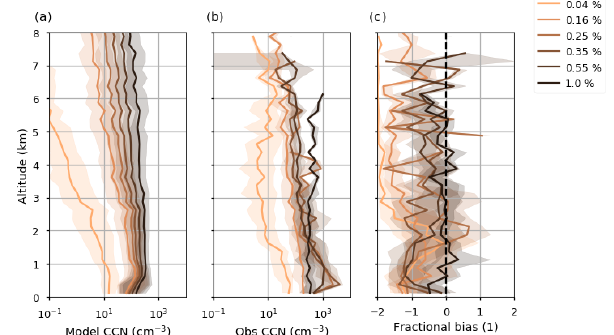
Figure 11. The vertical profile of median fractional bias in model and observed integrated aerosol number at different size cut-offs using SALSA.